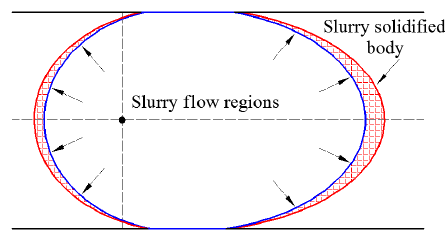
Figure 11. Formation process of waterpower infiltration jam.